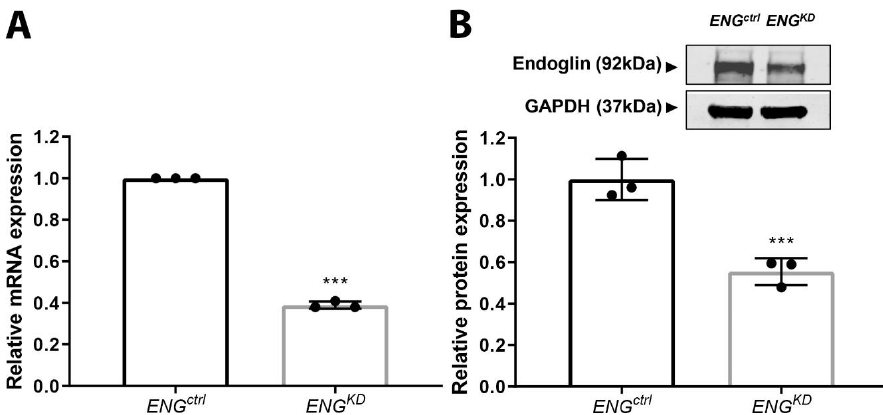
Figure 4. shRNA-mediated knockdown of endoglin expression in TK173 fibroblasts. ( A ) ENG mRNA levels were measured in TK173 cells expressing an empty vector control ( ENG ctrl ) and TK173 cells expressing an shRNA against ENG ( ENG KD ); data are depicted relative to ENG ctrl cells. ( B ) Western blot analysis of endoglin protein levels in ENG ctrl and ENG KD fibroblasts. GAPDH was used as a loading control. Data are shown relative to ENG ctrl cells. Data are presented as the mean ± SD from three experiments. *** p < 0.001 (Student’s t-test).